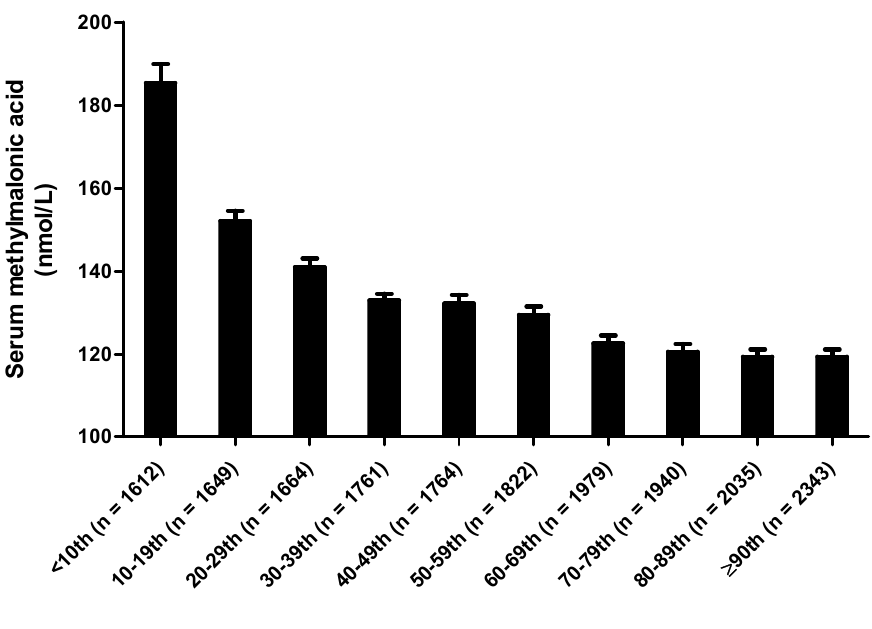
Figure 4. Serum vitamin B-12 stratified geometric mean concentrations of serum methylmalonic acid (MMA) for ≥ 12 years old persons in the US ( n = 18,569). Serum MMA concentrations were adjusted for sex, race-ethnicity, age, supplement use and serum creatinine. Analysis was performed on log MMA concentrations to satisfy normality.